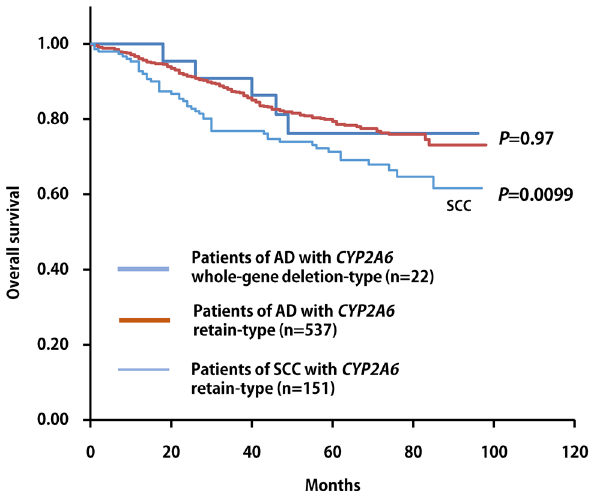
Figure 1. Kaplan–Meier survival curves for patients with or without whole-gene deletion-type of CYP2A6 in lung adenocarcinoma and squamous cell carcinoma with CYP2A6 retain-type.